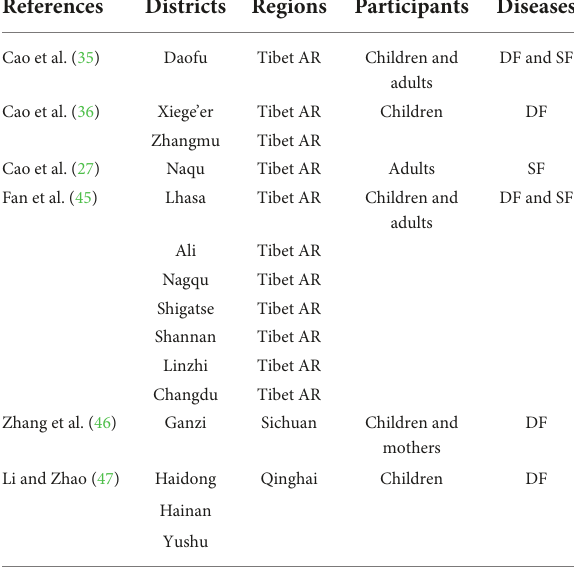
TABLE 1 Included studies on brick tea-type